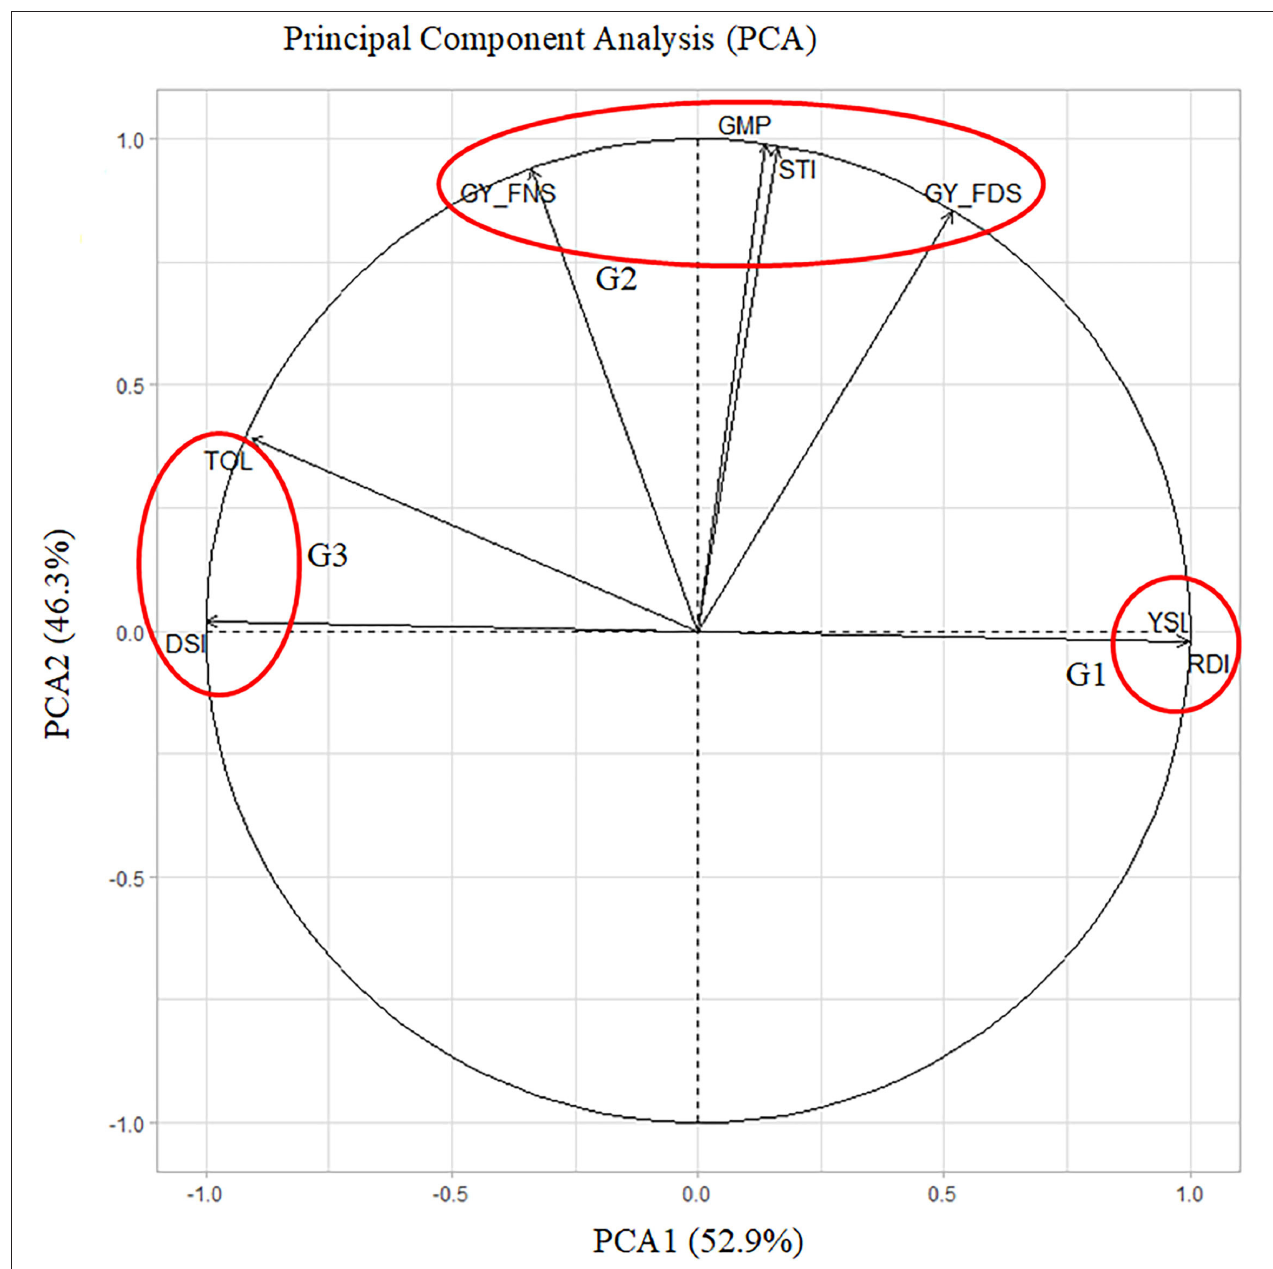
FIGURE 3 | PCA showing the contribution of drought indices. PCA1 and PCA2 accounted for 99.2% of total variations among drought